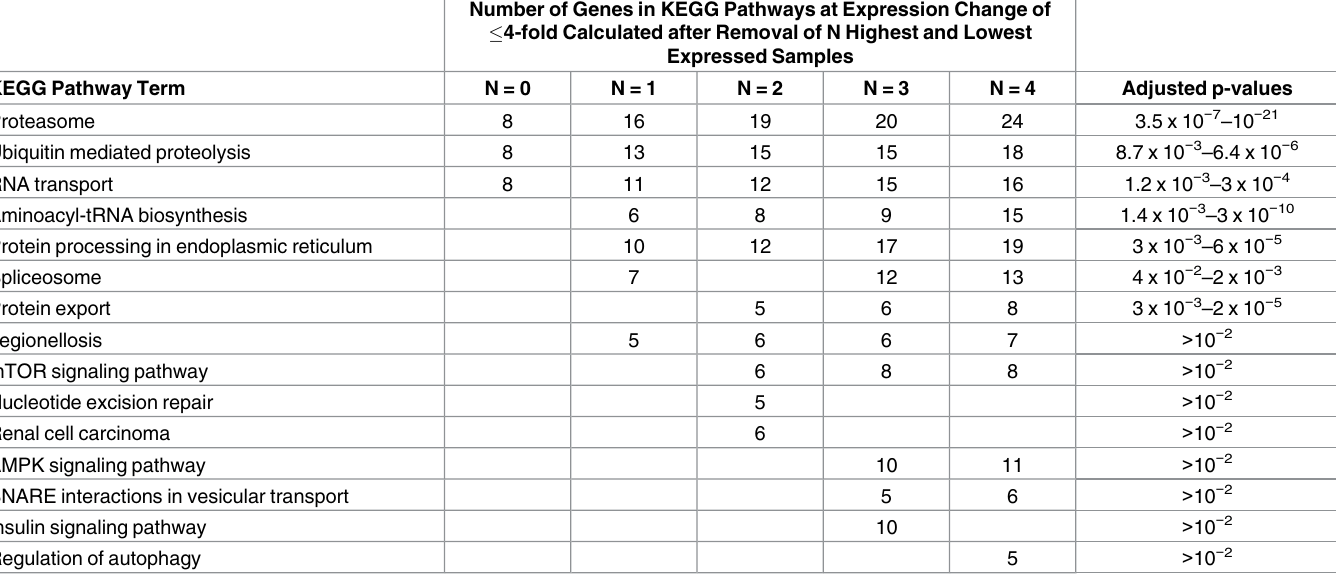
To understand the effect of changing the cutoff values on the types of genes and pathways identified, we adjusted the number of highest and lowest expressed genes to remove. Using an expression change of (cid:20) 4-fold and removing no samples, the highest and lowest expressed 2 samples, 3 samples, and 4 samples, resulted in 146, 399, 513, and 660 genes (along the diagonal in Fig 2B, FC (cid:20) 4-fold panel). KEGG pathway analysis identified the same pathways as with the 278 SEGs, generally with increased significance level (Table 2; S1–S5 Tables). Examination of the significant pathways identified with cutoff criteria of expression changes of (cid:20) 3-fold (44 SEGs; S6 Table) and (cid:20) 5-fold (691 SEGs; S7 Table) calculated by using second highest and low- est samples (with exclusion of the single highest and single lowest expressed samples) also identified similar pathways involving protein degradation and processing, although with the expression change of (cid:20) 3-fold, only 17 of the 44 SEGs were associated with any KEGG path- way. Thus, our selection criteria appear to be robust and making small adjustments in them identify the same major pathways involved in protein degradation and processing. Table 2. SEGs with expression changes of (cid:20) 4-fold–the number of genes in stably expressedpathways increaseswith relaxed selection criteria. Number of Genes in KEGG Pathways at Expression Change of (cid:20) 4-fold Calculated after Removal of N Highest and Lowest Expressed